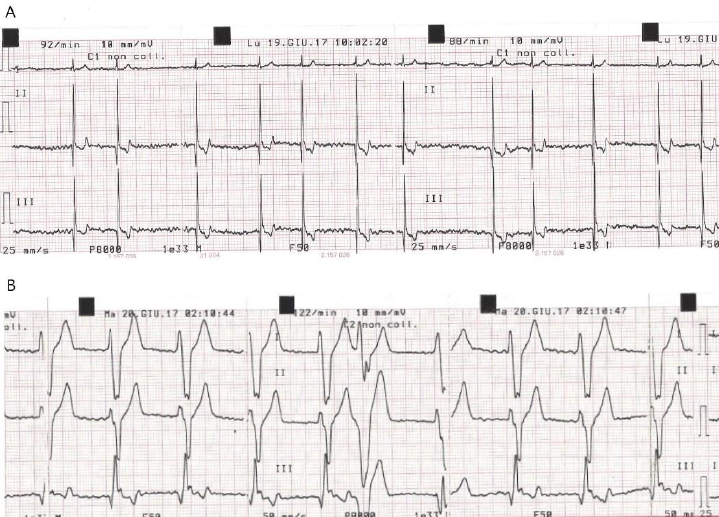
Figure 3. Dog C10 (Schnauzer M, 8 years old). ( A ) ECG recorded at D0 before gene delivery procedure. ( B ) ECG recorded at 5 h post procedure.